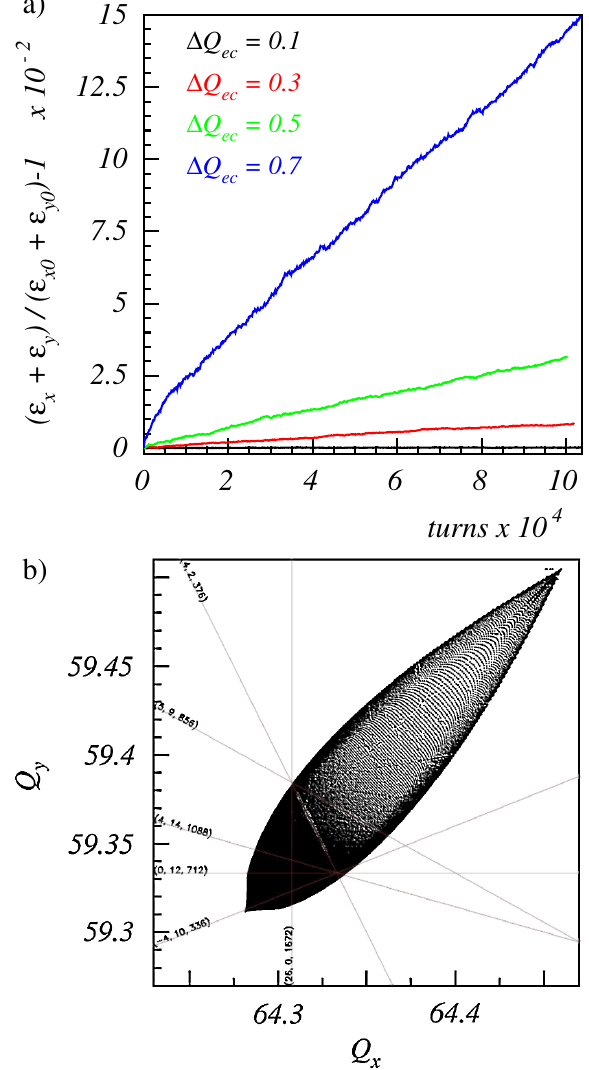
FIG. 13. (Color) RHIC beam emittance evolution versus turns ¼ 0 : 03 (top); frequency map for RHIC for a beam with for (cid:1) Q ec ¼ 0 : 1 (bottom). (cid:1) Q ec